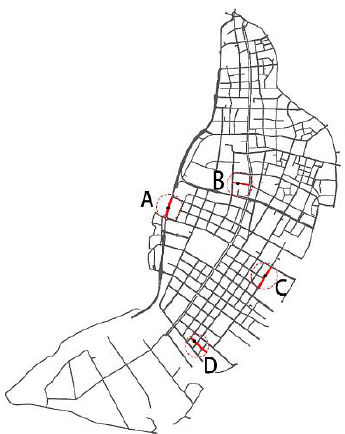
Figure 8. Distribution of observation points in study area.